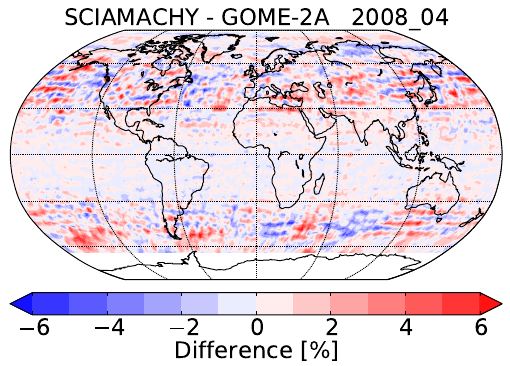
Figure 5. Percentage differences between SCIAMACHY and GOME-2A monthly mean total ozone for April 2008.